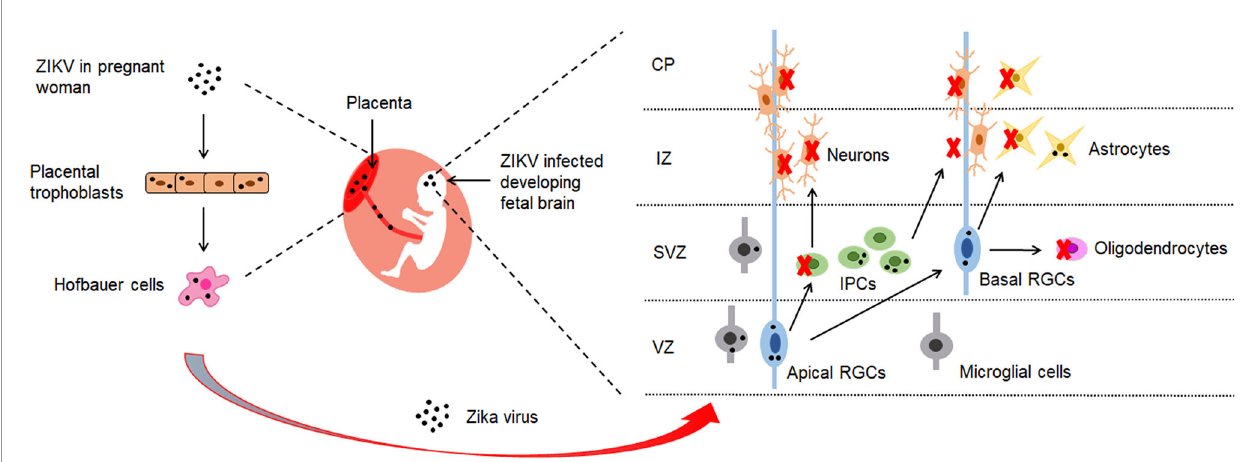
FIGURE 1 | The brain cells targeted by ZIKV. ZIKV has shown to possess the ability to cross the placental barrier of infected pregnant women (8). It reaches fetal brains through placenta by infecting placental trophoblasts and Hofbauer cells (7, 9). In the developing fetal brain, ZIKV has demonstrated to mainly target radial glial cells (RGS) in the ventricular zone (VZ) and intermediate progenitor cells (IPCs) in the sub-ventricular zone (SVZ) (8, 10). During brain development, cortical stem cells give rise to radial glial cells (RGCs) which proliferate into progenitor cells that make up the brain and central nervous system. RGCs generate IPCs which divide and generate the majority of neurons in the brain. The neurons migrate through intermediate zone (IZ) to the developing cortical plate (CP) (11, 12). ZIKV infection in the fetal brain has resulted in depletion of IPCs and differentiating neurons, and has caused reduction of thickness of VZ, SVZ and CP layers (13). Numerous studies provide evidence that ZIKV has shown to induce apoptosis, cell cycle dysregulation and immune response in neuronal cells, which leads to impaired neurogenesis and